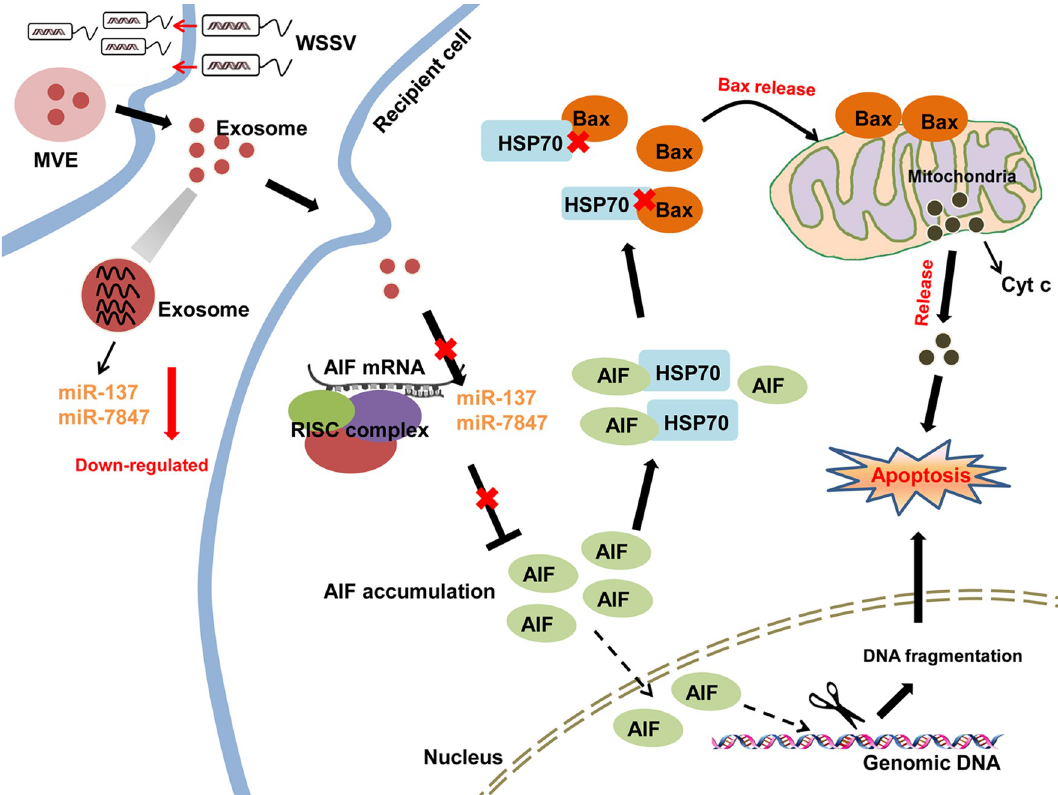
Fig 8. Proposed schematic diagram for the exosomal miR-137 and miR-7847-mediated apoptosis and virus invasion regulation in mud crab.